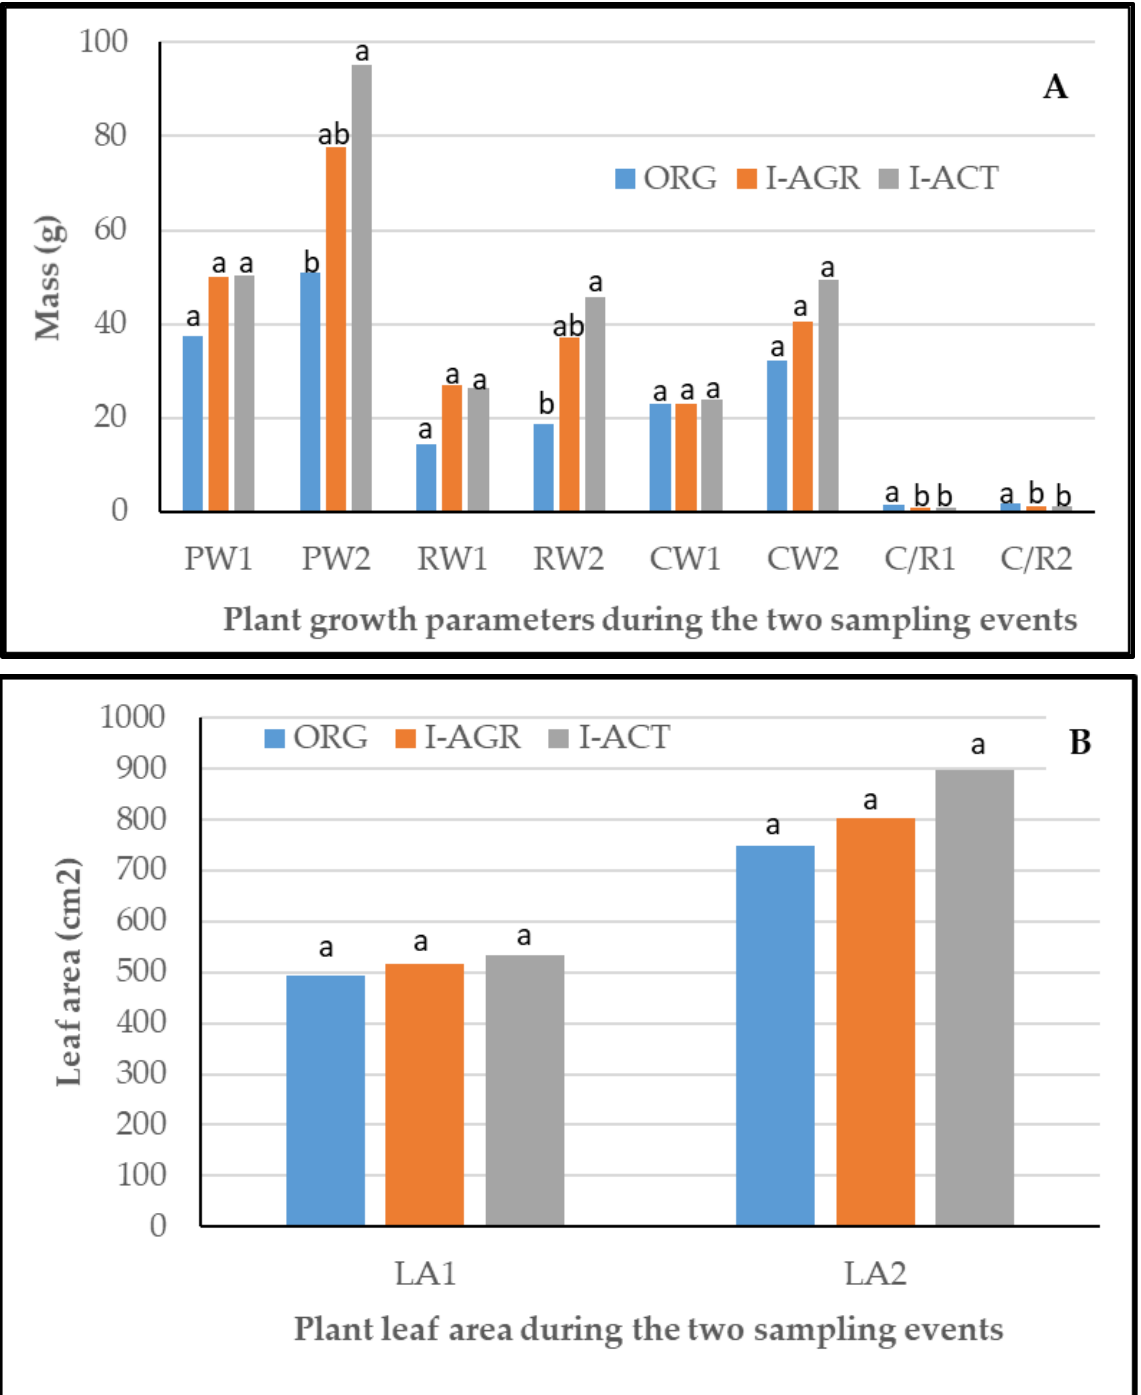
Figure 2. Effect of cultivation management on plant weight ( A ) and leaf area ( B ) during the two sampling events (26 of March (1) and 20 of May (2)). PW, plant weight; RW, root weight; CW, above ground plant weight, C/R, above ground versus root weight; LA, leaf area; ORG, organic; I-AGR, integrated based on Agrobiosol amendment; I-ACT, integrated based on Activit amendment. Different letters above each column within the same parameter evaluated, indicate significant differences among treatments based on Tukey HSD multiple range test at a=0.05.